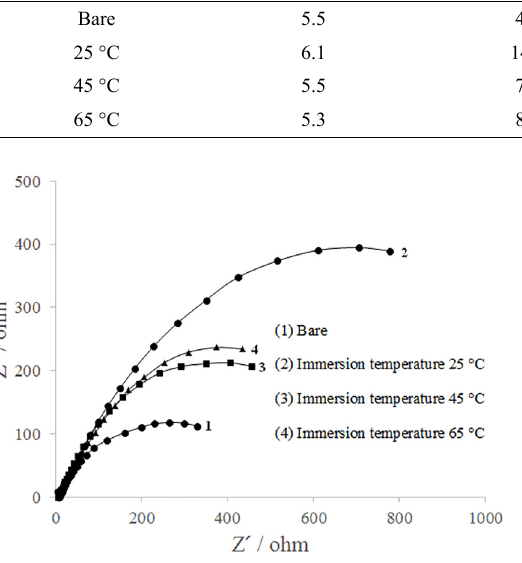
Figure 5. The Nyquist plots of cerium-coated steel in 3.5 wt% NaCl solution. Conversion coatings were obtained by 60 s immersion time in cerium solution in different temperatures: (1) bare, (2) 25 °C, (3) 45 °C and (4) 65 °C.